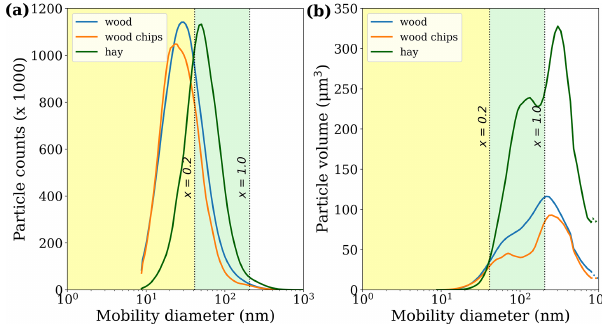
Figure 9. Particle size distribution of the different fuel types. (a) Absolute particle counts in the respective mobility diameter bins. (b) The particle volume represented by the particles counted in the mobility diameter